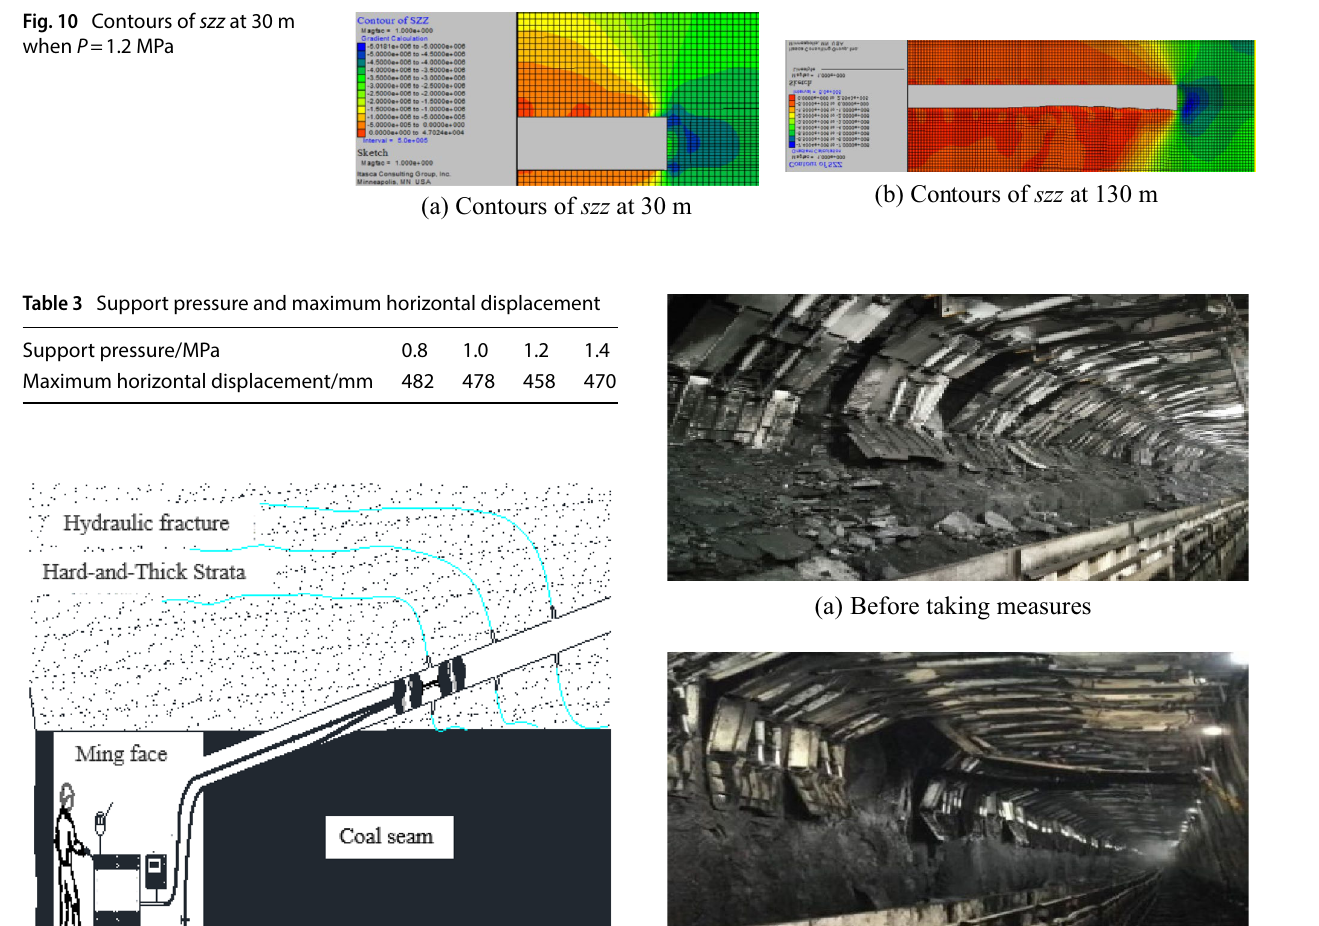
Fig. 10 Contours of szz at 30 m when P = 1.2 MPa